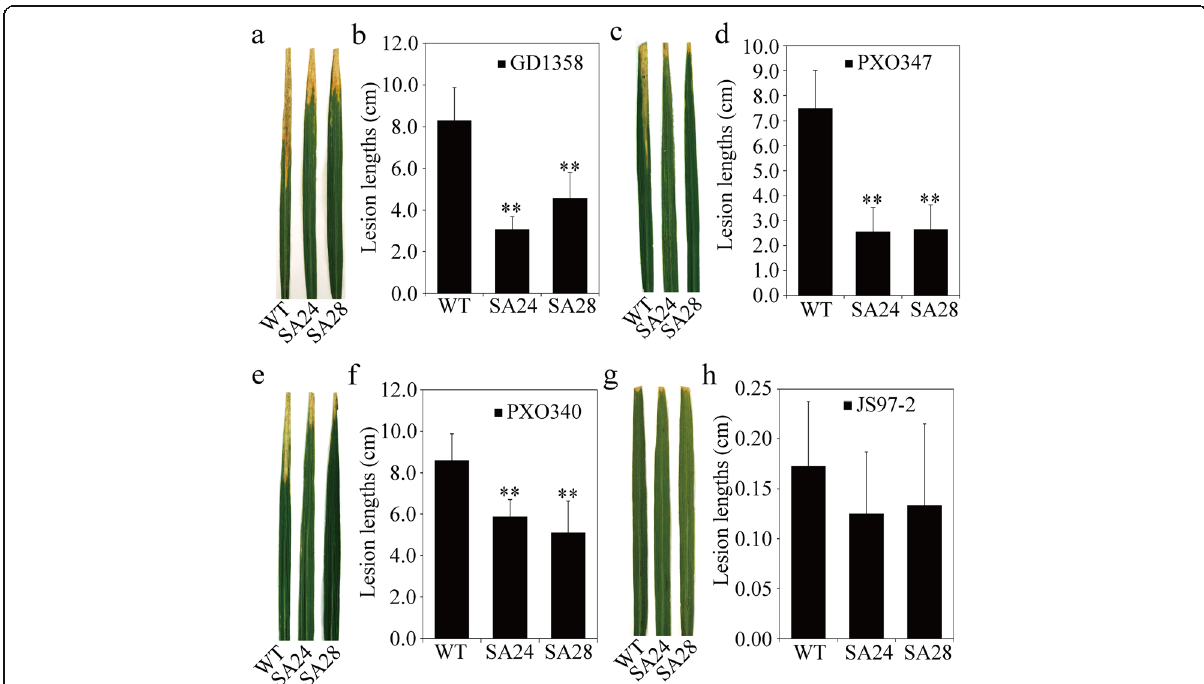
Fig. 6 Phenotypic responses of OsSGT1 - overexpression ( OsSGT1-OE ) and wild-type (WT) plants inoculated with Xanthomonas oryzae pv. oryzae ( Xoo ). a and (b) Phenotypes of OsSGT1-OE and WT plants, respectively, inoculated with Xoo strain GD1358. c and (d) Phenotypes of OsSGT1-OE and WT plants, respectively, inoculated with Xoo strain PXO347. e and (f) Phenotypes of OsSGT1-OE and WT plants, respectively, inoculated with Xoo strain PXO340. g and (h) Phenotypes of OsSGT1-OE and WT plants, respectively, inoculated with Xoo strain JS97 – 2. Photographs were taken 12 d after inoculation. The lesion lengths were measured 12 d after inoculation with Xoo strains. Values are presented as the means and standard errors of three replicates. * P < 0.05, according to a Student ’ s t